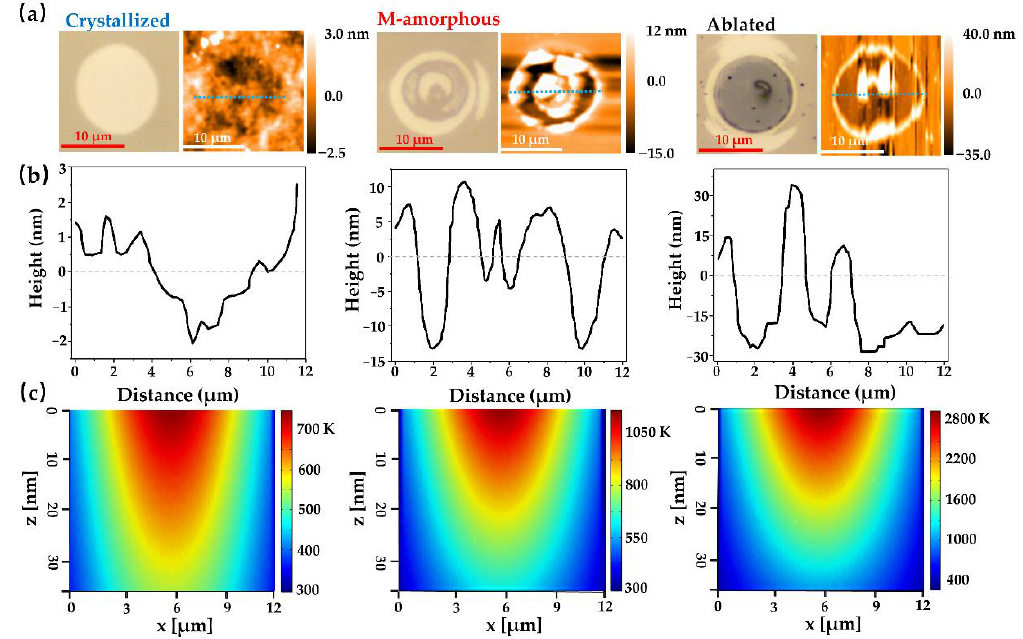
Figure 2. ( a ) Optical microscopy image (left) and AFM topography (right) of three categories of irradiation marks on the a-GST background film; ( b ) the heights distribution corresponding to cross- sectional views of blue dotted line in AFM topography; ( c ) thermal simulations of three categories of irradiation marks.